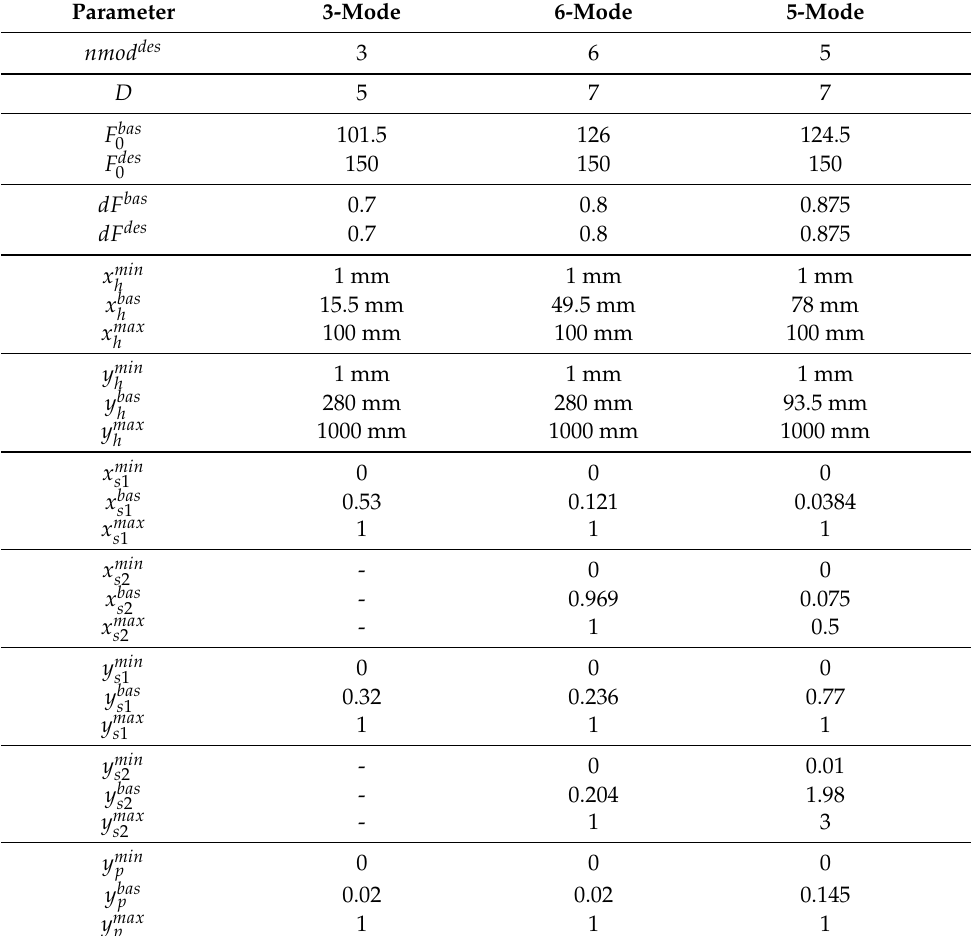
Table 1. Algorithm parameters for three cases.